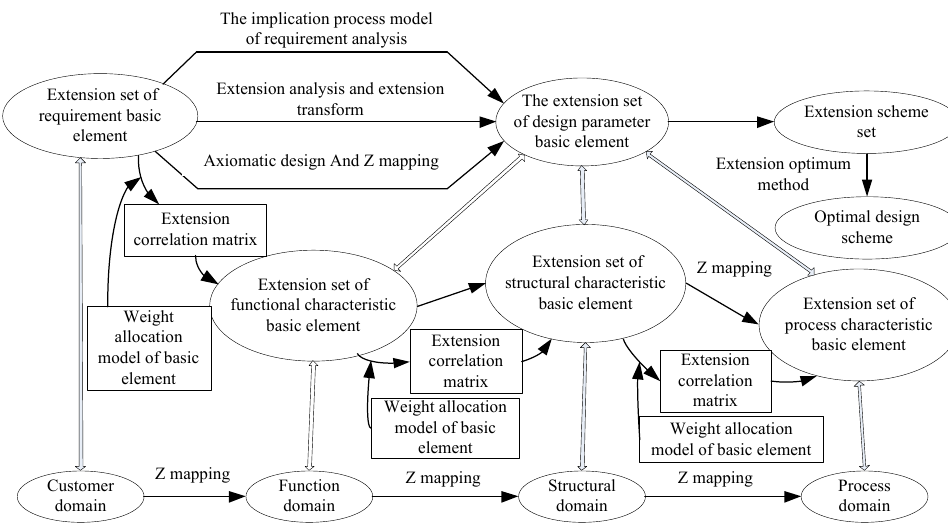
Figure 2. The extension design pattern of requirement analysis of conceptual product design.